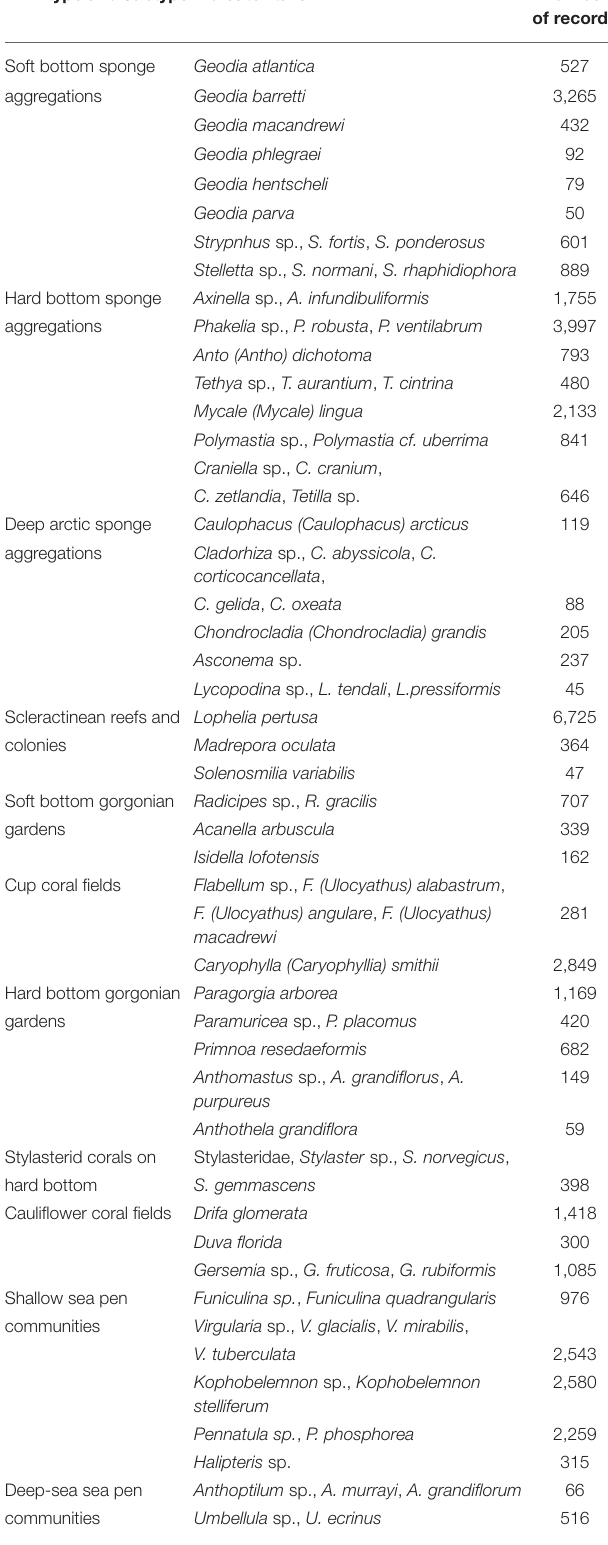
TABLE 1 | List of the 44 VME indicator taxa selected for modeling using